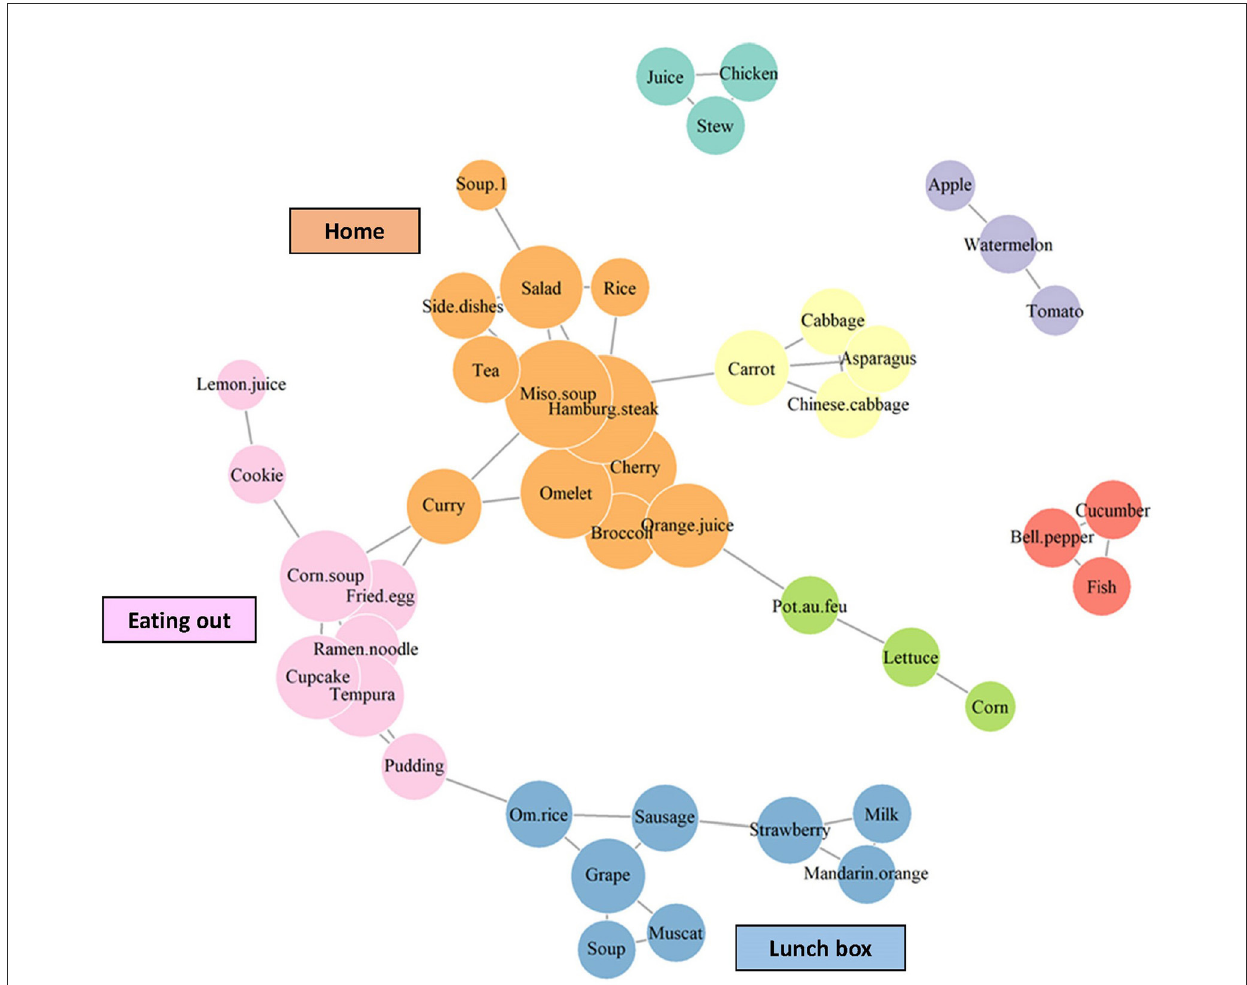
FIGURE1 Co-occurrence network of food items in drawings of first and second graders . The size of an item’s circle corresponds to the number of lines connecting it to other items. Unique colors are used to identify nodes defined by Jaccard similarity